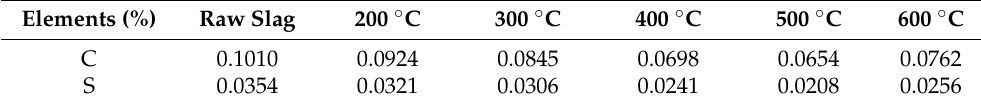
Table 7. TS/TOC element analysis diagram of tantalum niobium slag.